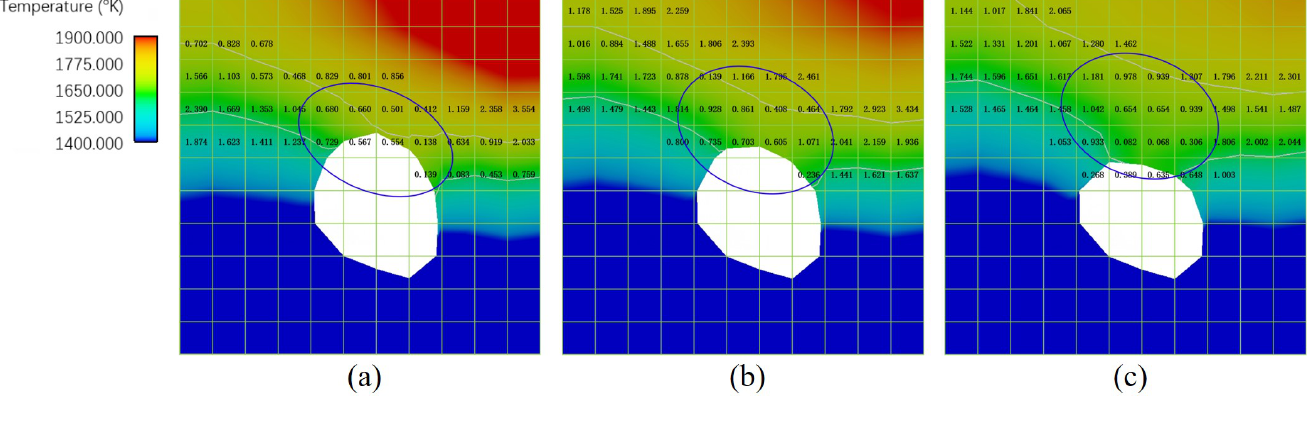
Figure 26. The cooling rate (with the order of ( 10 6 K/s ) ) near the mushy zone around pore a : ( a ) results at t = 9.3 × 10 − 4 s, ( b ) results at t = 9.5 × 10 − 4 s ( c ) results at t = 9.7 × 10 − 4 s, where the two white curves represent the solidus temperature and liquidus temperature isotherms. The cooling rate of the cells above the pore outlined by the blue curves is smaller than that of the neighboring cells in the mushy